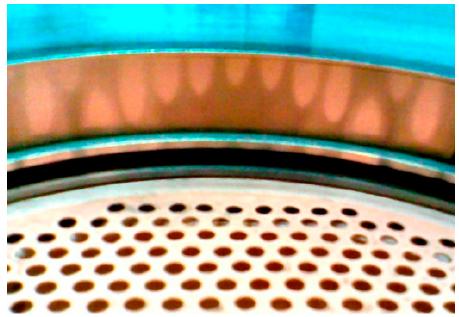
Figure 7. Imprints of ions passing through peripheral apertures of the grid.